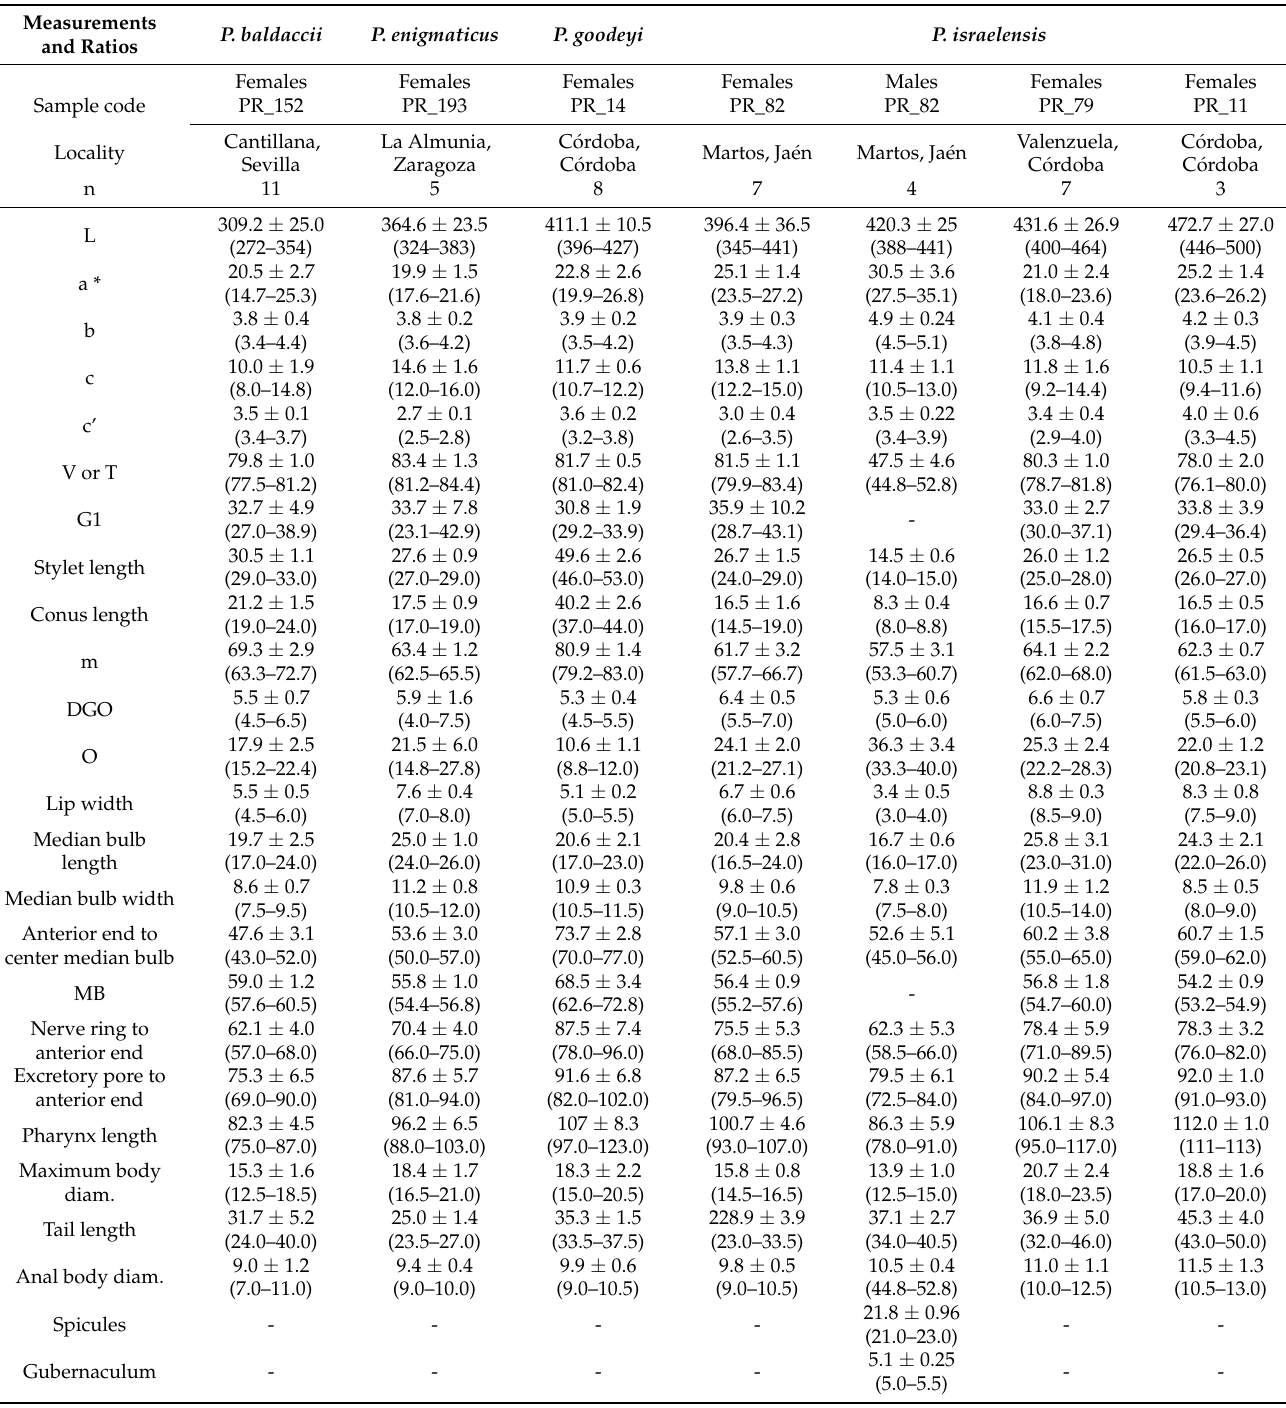
Table 6. Morphometrics of Paratylenchus baldaccii Raski, 1975, Paratylenchus enigmaticus Munawar, Yevtushenko, Palomares- Rius & Castillo, 2021, Paratylenchus goodeyi (Oostenbrink, 1953) Raski, 1962, Paratylenchus holdemani Raski, 1975 and Paratylenchus israelensis (Raski, 1973) Siddiqi, 1986 from several localities in Spain. All measurements are in µ m and in the form: mean ± s.d.